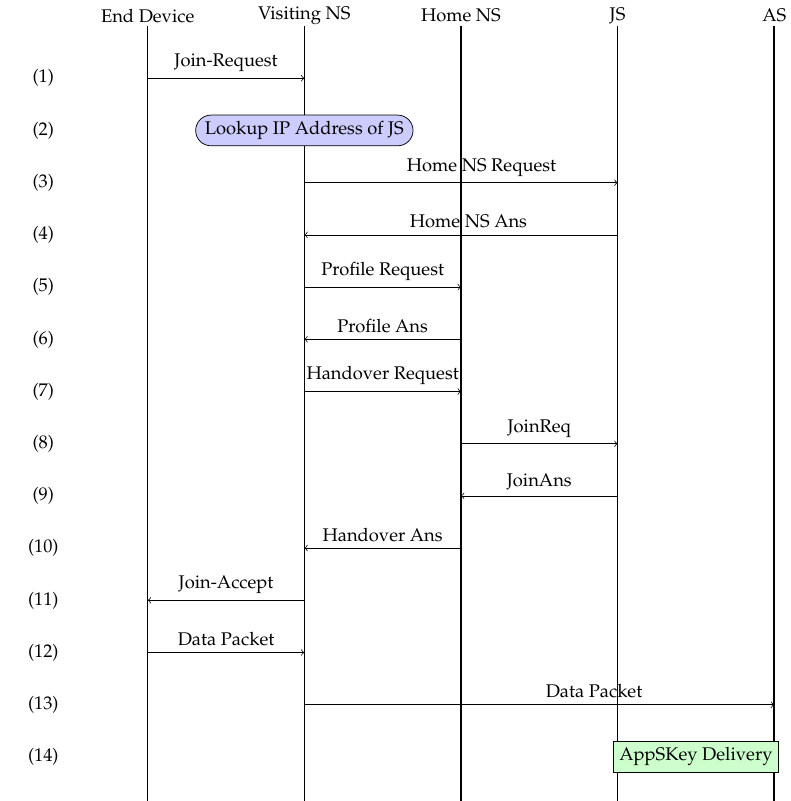
Figure 4. Flow chart of operations for joining a visiting network. JS and AS denote the join server and the application server,